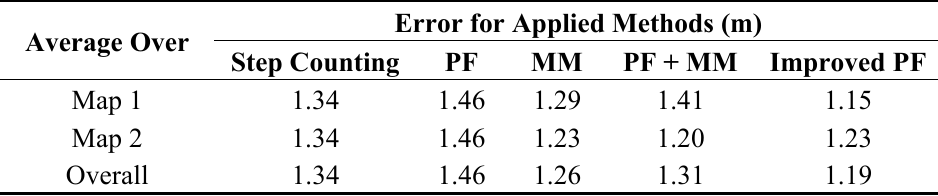
Table 7. Average error for each map and